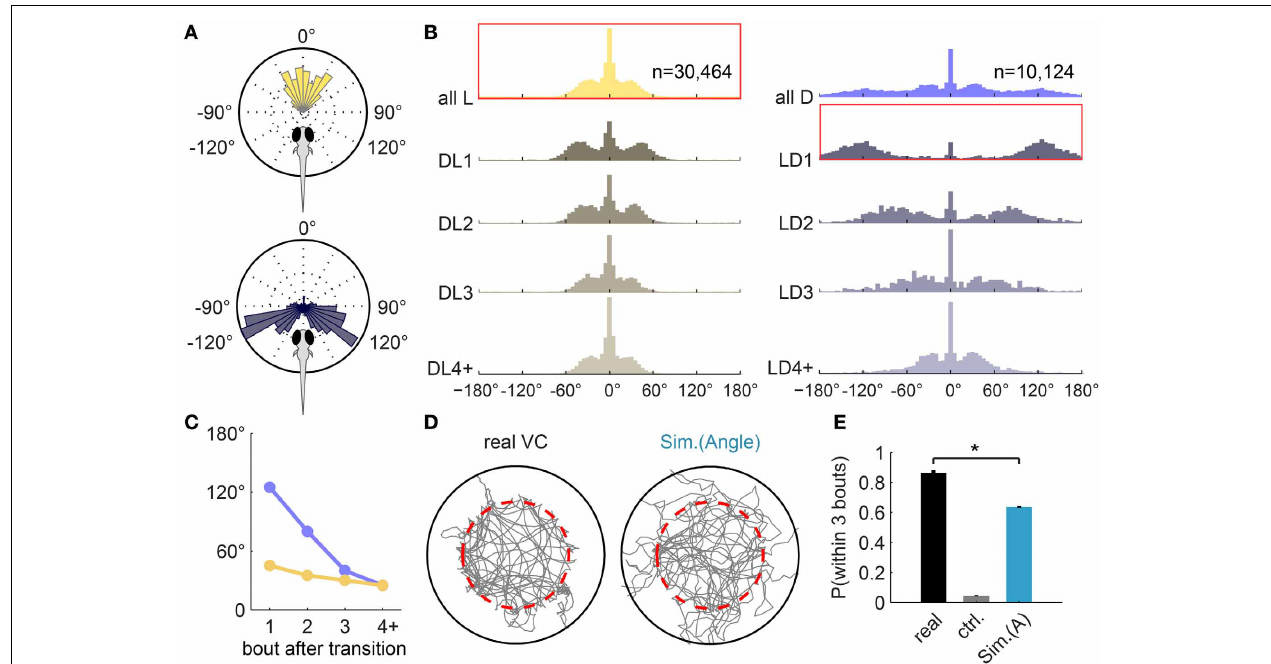
FIGURE 2 | Turning-angle distributions in the light, in the dark, and at transitions. (A) Turning-angle distributions from an example fish. Upper panel: all turns in light. Lower panel: the first turn after the Light-to-Dark transition (LD1) is usually a large angle turn. (B) Turning-angle distributions from all 32 fish, for bouts in light (left panel) and in dark (right panel). The top two histograms summarize all turns made in light (left) and in dark (right), respectively. “DL n ”: the n -th turn after a Dark-to-Light transition. DL4 + : all subsequent turns in the dark. “LD”: respective turns in response to a Light-to-Darktransition.Histogramsframedinredcorrespondtothesingle-fish polar plots in (A) . (C) Mean turning angle—after excluding center peaks—of